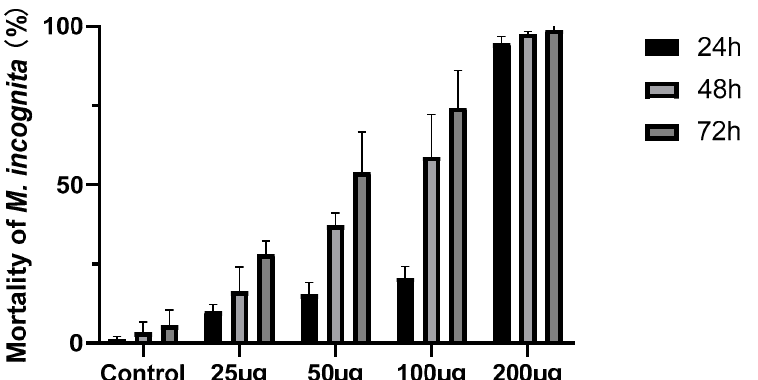
Figure 5. Nematicidal activity of compound 4 against M. incognita at different concentrations. Error bars represent the standard error of the mean ( n = 3).